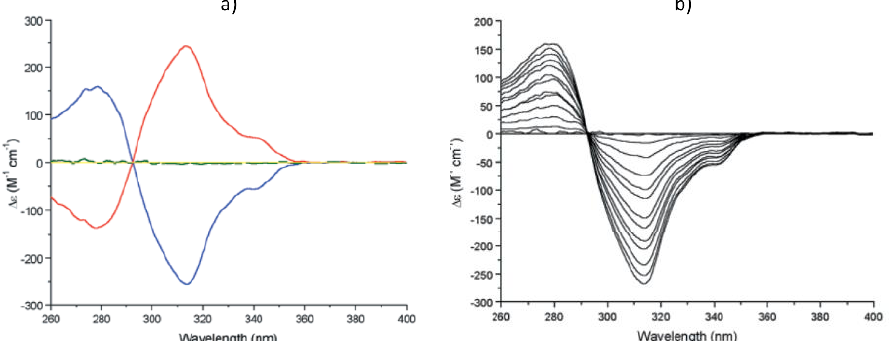
Figure 9. ( a ) CD spectra of (–)-R-pinene (yellow line), oligomer (green line) in the presence of 100 equiv of (–)-R-pinene (blue line) and 100 equiv of (+)-R-pinene (red line). ( b ) CD spectra of oligomer 1 as a function of the (–)-R-pinene concentration [32].